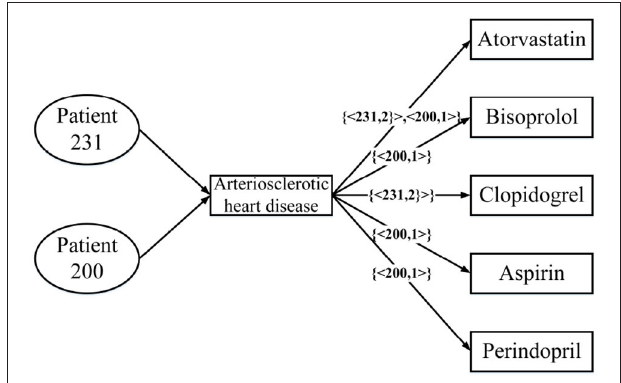
FIGURE 3 | An annotated HIN from Table 1 .